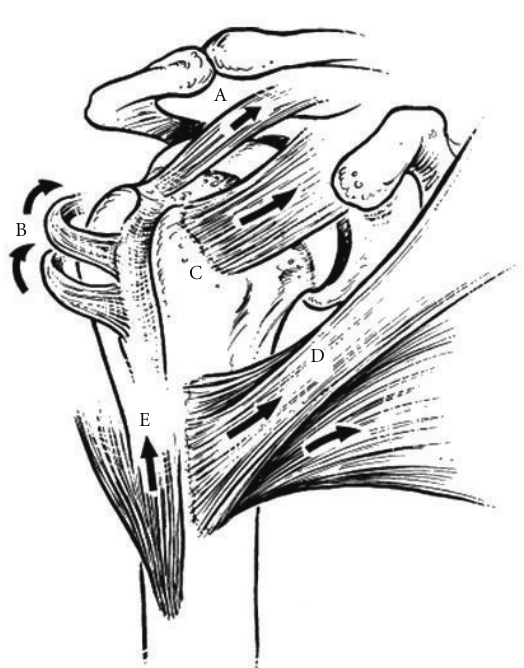
Figure 1: This drawing demonstrates the deforming forces on the proximal humerus in the setting of fracture. The supraspinatus (A) exerts a force posteromedially. The infraspinatus and teres minor (B) pull posteromedially and externally rotate. The subscapularis (C) exerts an anteromedially directed force on the lesser tuberosity. The pectoralis major (D) internally rotates and adducts, while the deltoid (E) pulls superiorly on the metadiaphysis of the humerus. (Reprinted with permission from Gruson et al. [4]).